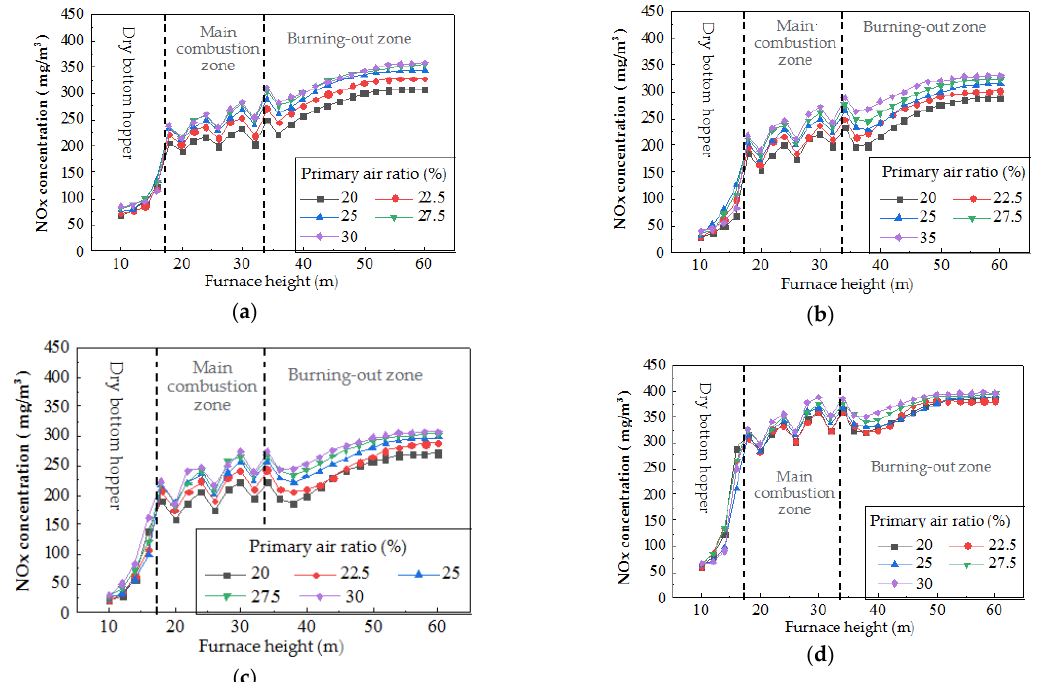
Figure 15. Variation in NOx concentration along the furnace height under different primary air ratio: ( a ) Variation in NOx concentration along the furnace height under different primary air ratio and 600 MW boiler load; ( b ) Variation in NOx concentration along the furnace height under different primary air ratio and 500 MW boiler load; ( c ) Variation in NOx concentration along the furnace height under different primary air ratio and 400 MW boiler load; ( d ) Variation in NOx concentration along the furnace height under different primary air ratio and 250 MW boiler load.